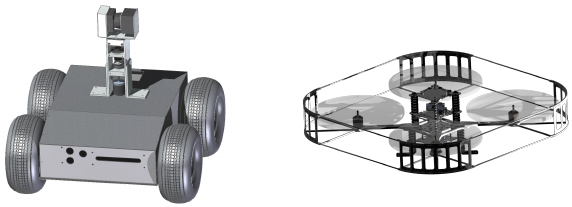
Figure 1: Robots used for terrestrial experiments. On the left: UGV (DrRobot Jaguar 4x4 Wheel). On the right: UAV